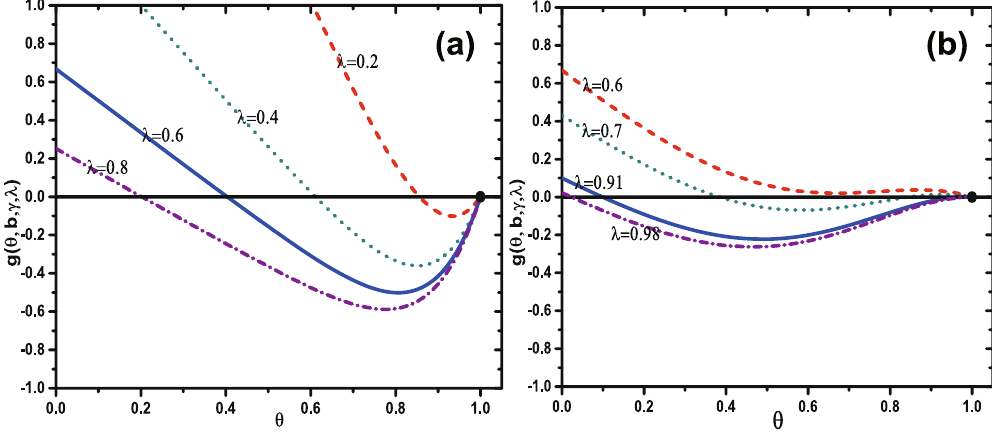
Figure 2. Demonstration of graphical solutions of Eq. (18) for b = 0.1 ( a ) and b = 0.9 ( b ). The horizontal axis are colored black and the tangent points are denoted as black dots.